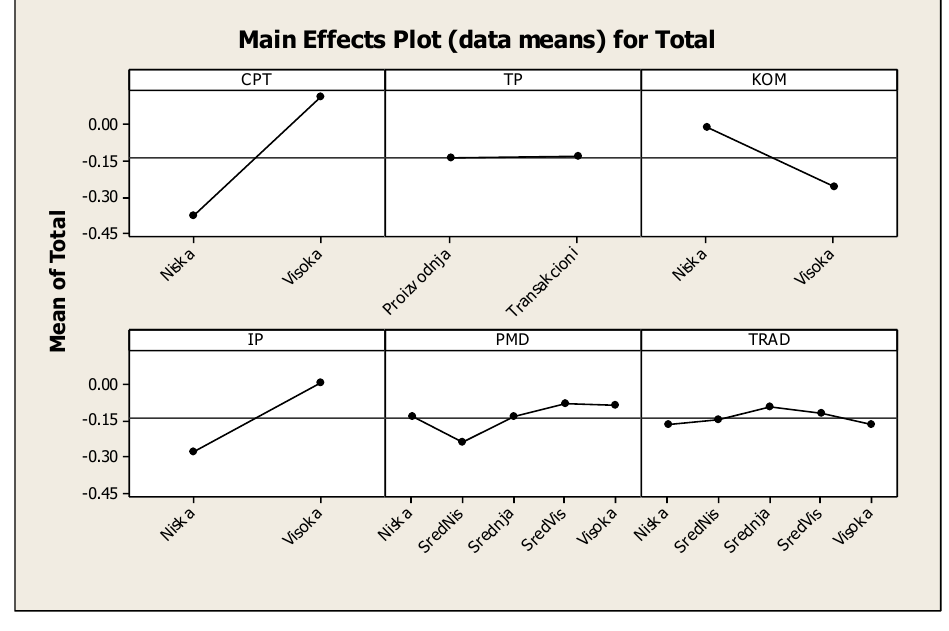
Fig. 13. Main effects plot for "Total"